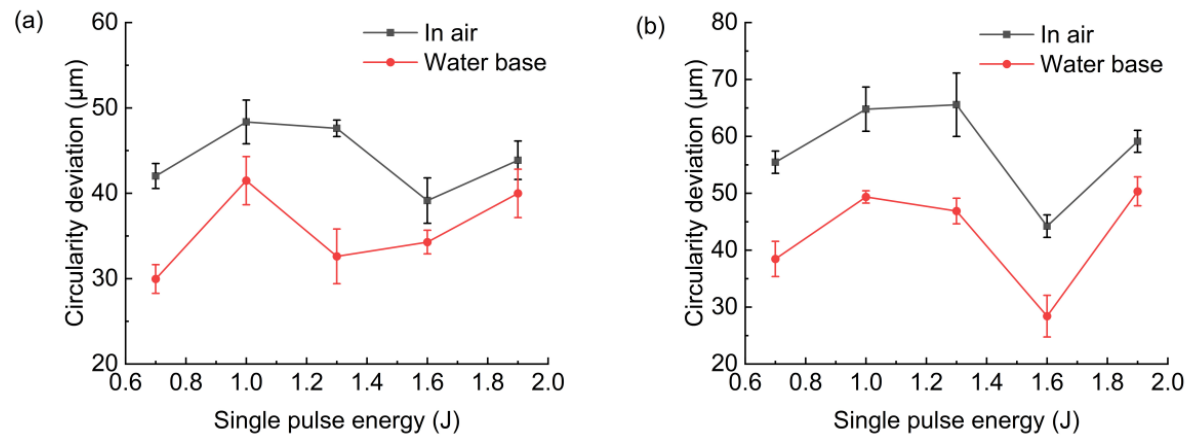
Figure 7. Effect of pulse energy on hole circularity deviation: ( a ) hole entrance, ( b ) hole exit.